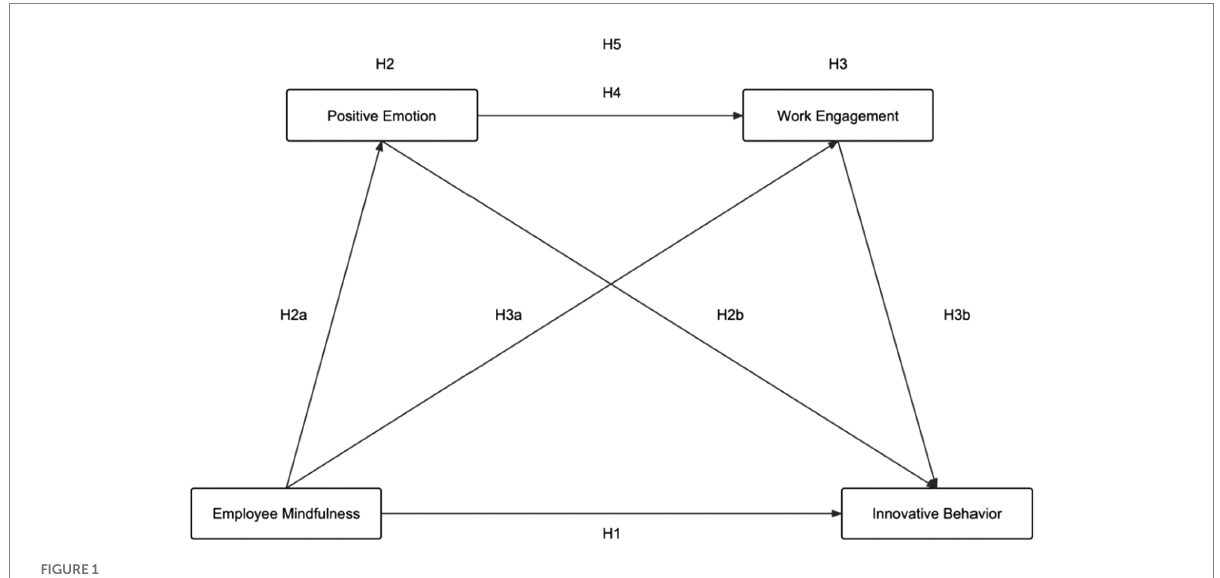
FIGURE 1 Research model and